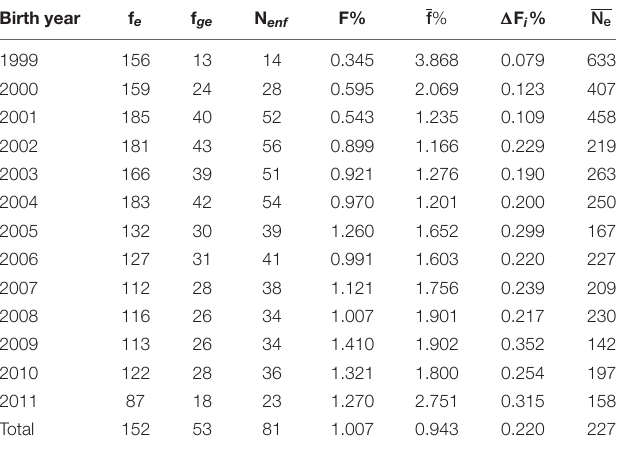
TABLE 5 | Effective number of founders (f e ), founder genome equivalent (f ge ), effective number of non-founders (N enf ), average inbreeding coefficients (F%), average coancestry (f%), average individual increase in inbreeding ( (cid:49) F 1 %), and effective population size (N e ) for the groups by birh year. Birth